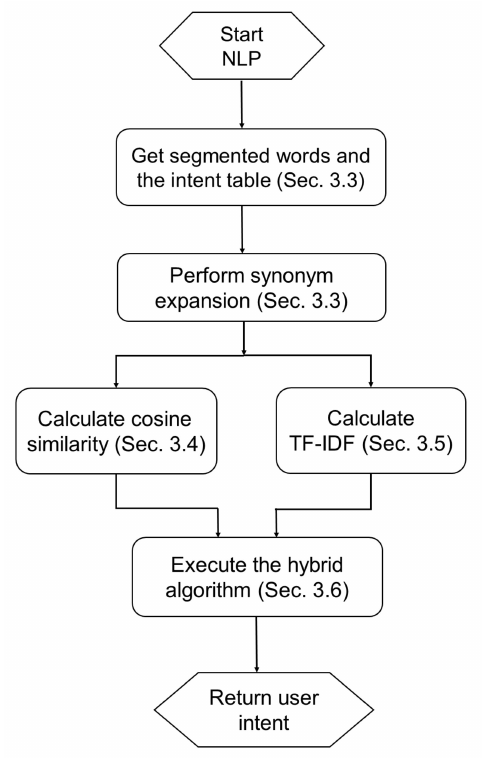
Figure 3. The flowchart of natural language processing